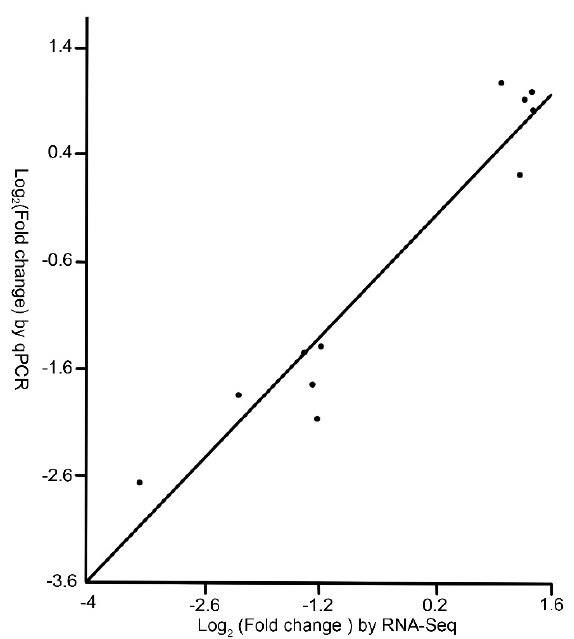
Figure 2. Correlation between qPCR data and RNA-Seq data. Each point represents the ratio of the average expression level of a gene in the M group to that in the C group. The data were log 2 transformed. See note for Table 1.